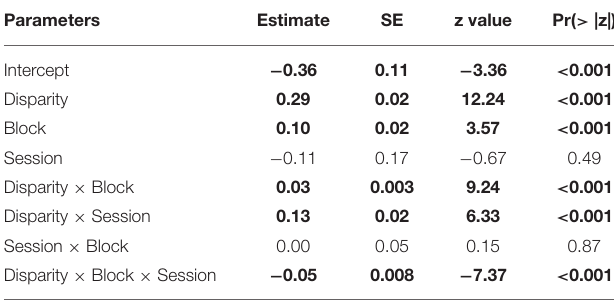
TABLE 1 | The generalized mixed-effects model for depth-discrimination responses with disparity, block, session, and their interactions as fixed effect